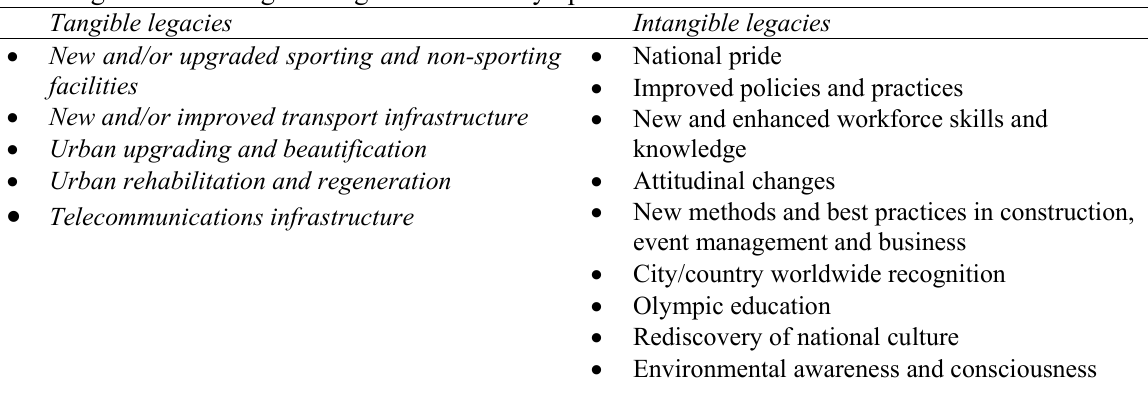
The Tangible and Intangible Legacies of the Olympic